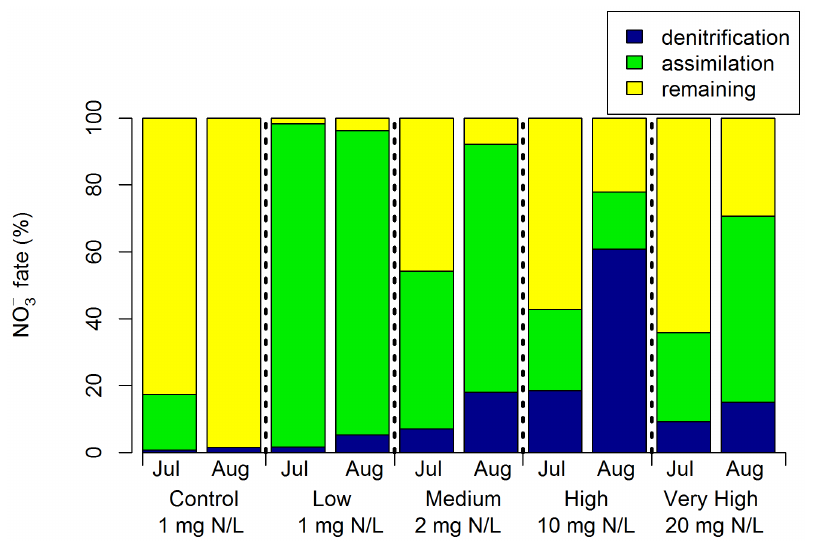
Figure 4. Division of 15 NO 3 2 between denitrification, plant or microbial assimilation and remaining as 15 NO 3 2 within the pore water. Measured 12 hours after dosing during July and August in the control (non-vegetated) and low, medium, high and very high (vegetated) nutrient dosing rates (n=4).